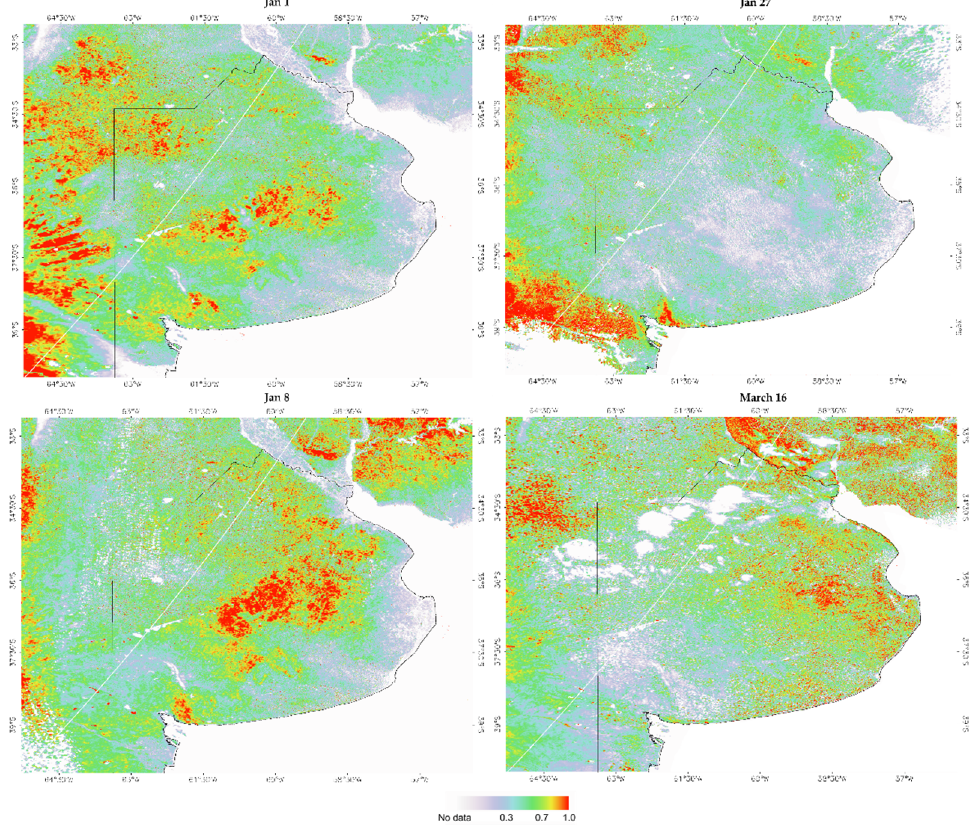
Figure 9. Examples of daily maps of TIDI at 500 m spatial resolution, without data for cloud cover and water bodies.